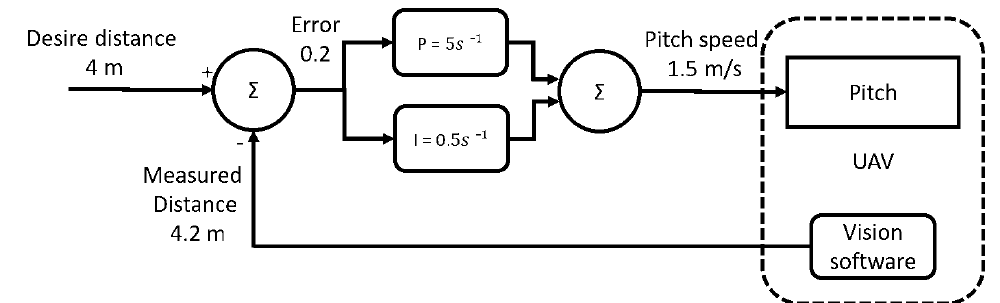
Figure 4. A proportional-integral control loop. The integral factor ensures that the error can decrease to 0.